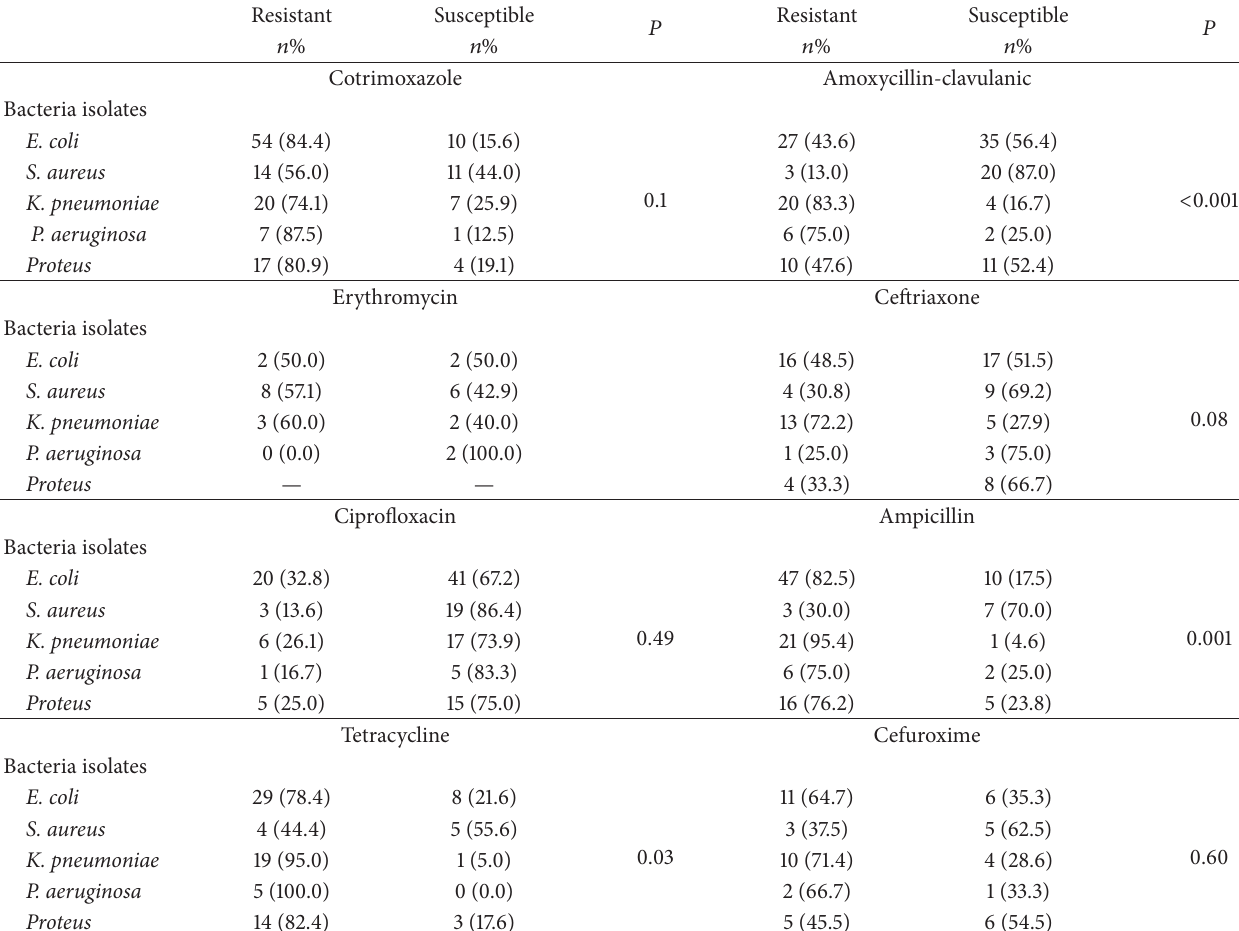
Table 2: Susceptibility data for common bacterial isolates to cotrimoxazole and other antimicrobials regardless of HIV or cotrimoxazole prophylaxis